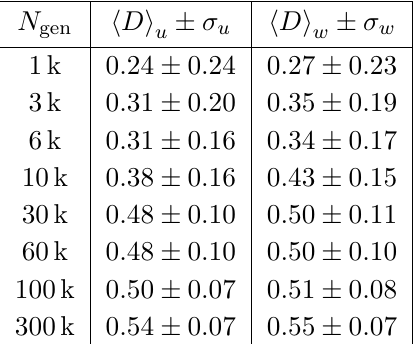
Table 7. Comparison of the classi(cid:12)ers D (calculated as weighted and unweighted averages) as function of the regenerated number of events N gen